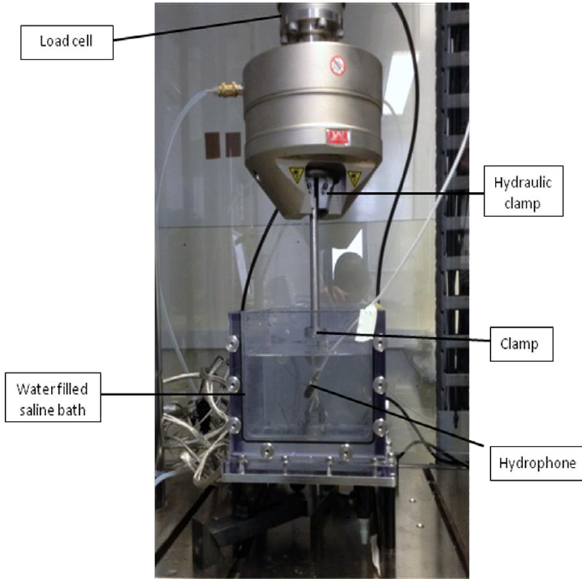
Figure 3. Instron test machine setup including saline bath and hydrophone.